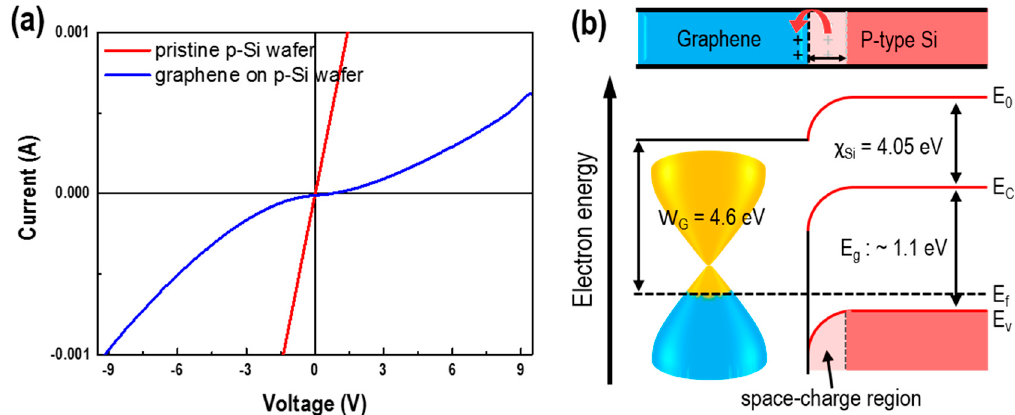
Figure 2. ( a ) Current-Voltage (IV) curve and ( b ) junction schematic of a pristine p-Si wafer and G- doped/p-Si sensors at room temperature.